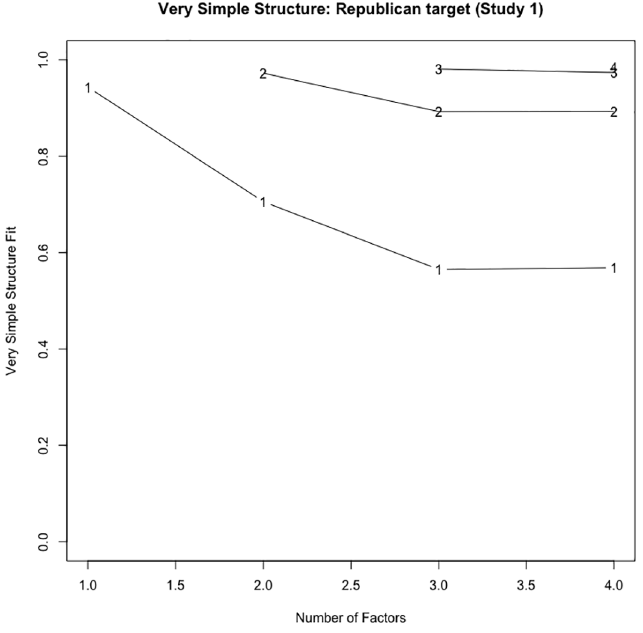
Figure A.2. Very simple structure analysis of Republican target trait ratings in Study